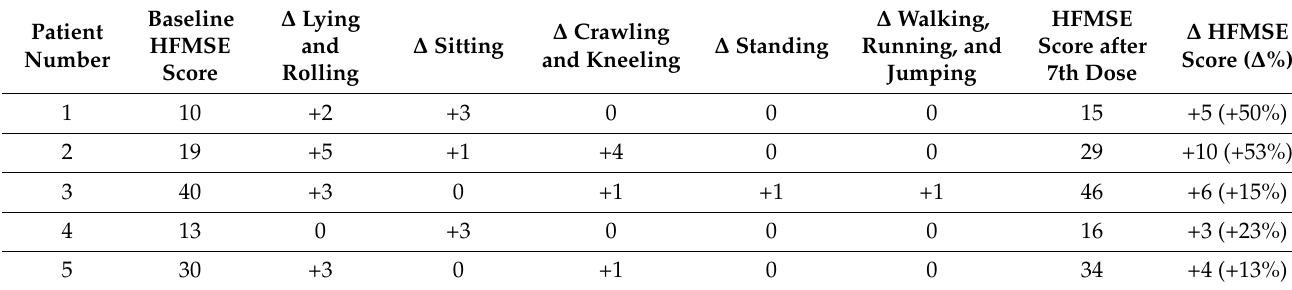
Table 2. Change in HFMSE scores from baseline after nusinersen injection.